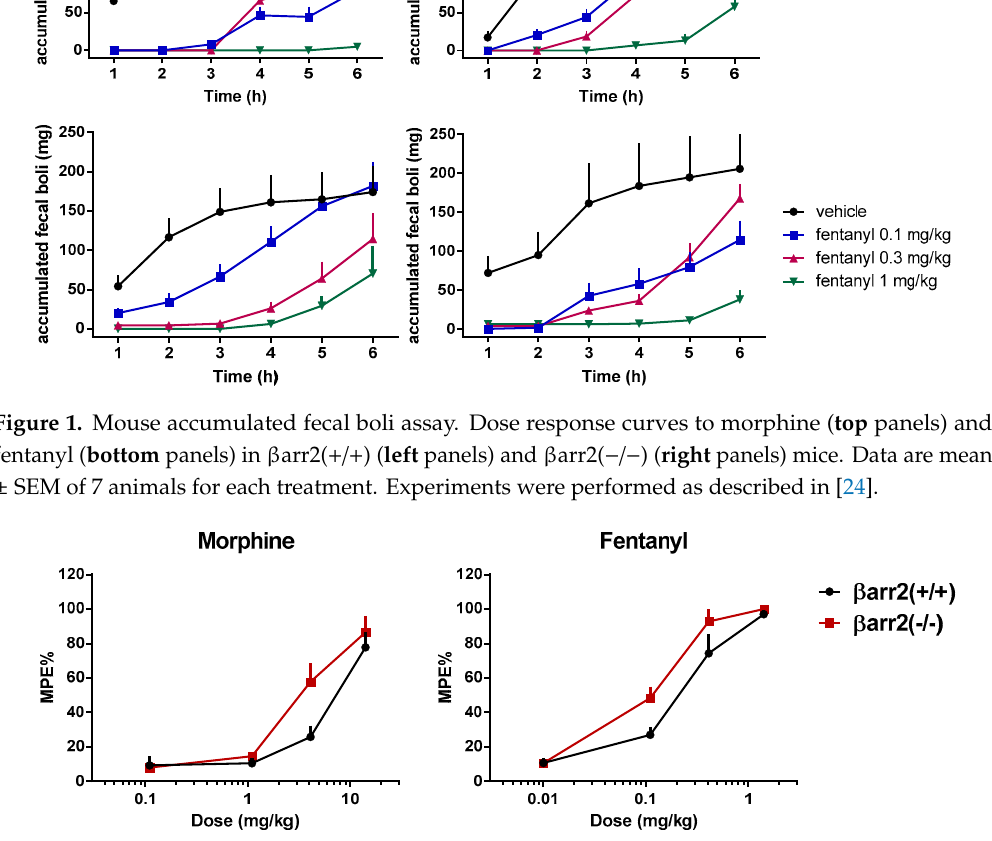
Figure 2. Mouse tail withdrawal assay. Dose response curves to morphine ( left panel) and fentanyl ( right panel) in β arr2( +/+ ) and β arr2( − / − ) mice. Data are mean ± SEM of 6 animals for each treatment. Experiments were performed as described in [32].